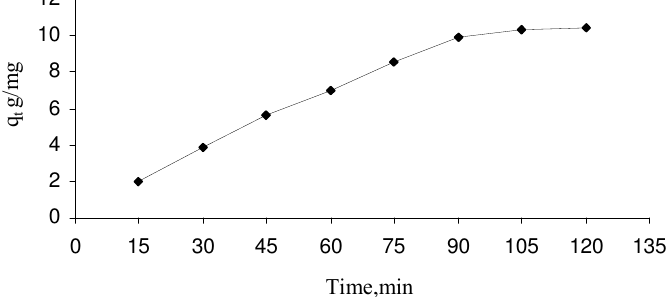
Figure 5. Effect of contact time on dye removal (pH=7, adsorbent dosage=0.8 g, dye solution=50